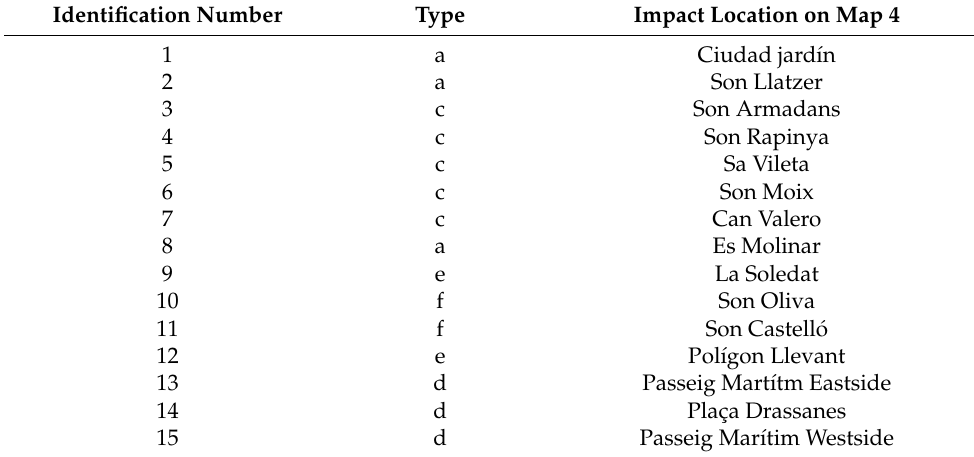
Figure 4. Map of impact points with identification number (Table 5) and zoning distribution. Table 5. Identification of points of